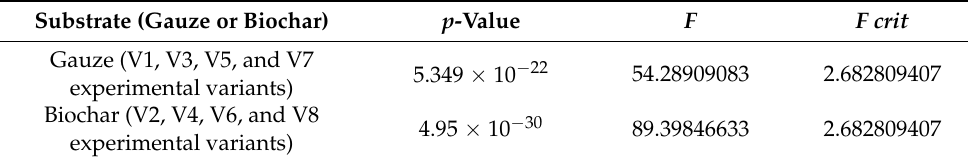
Table 1. A one-way ANOVA test for Lepidium sativum L. length sprouts.